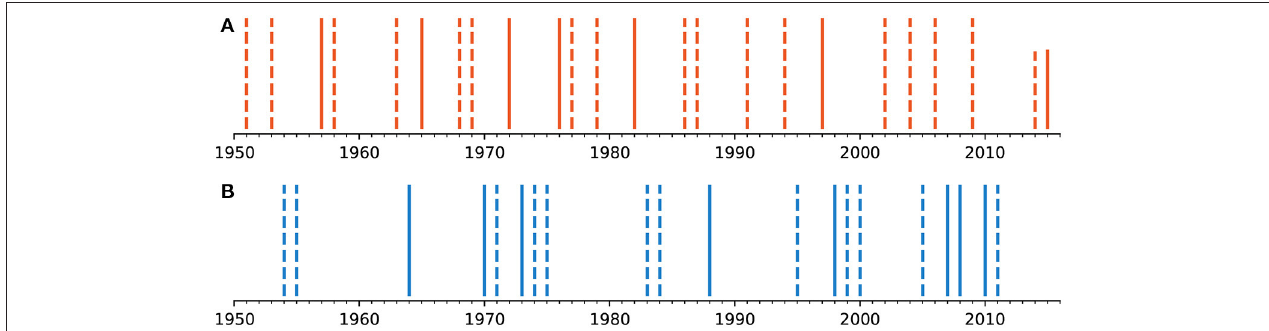
FIGURE 2 | (A) Exemplary seasonal precipitation time series P s , i ( t ) (colored bars) as well as corresponding thresholds p + s percentile of P s , i ( t ), respectively. Precipitation signals above p + s subsequent analysis. (B) The two corresponding event series P + s , i ( t ) and P − s , i ( t ) with P ± s , i ( t ) = 1 if a corresponding event occurs at time t and P ± s , i ( t ) = 0